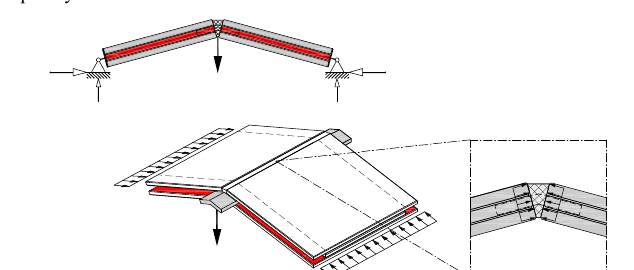
Figure 4: Steel elements at the corners